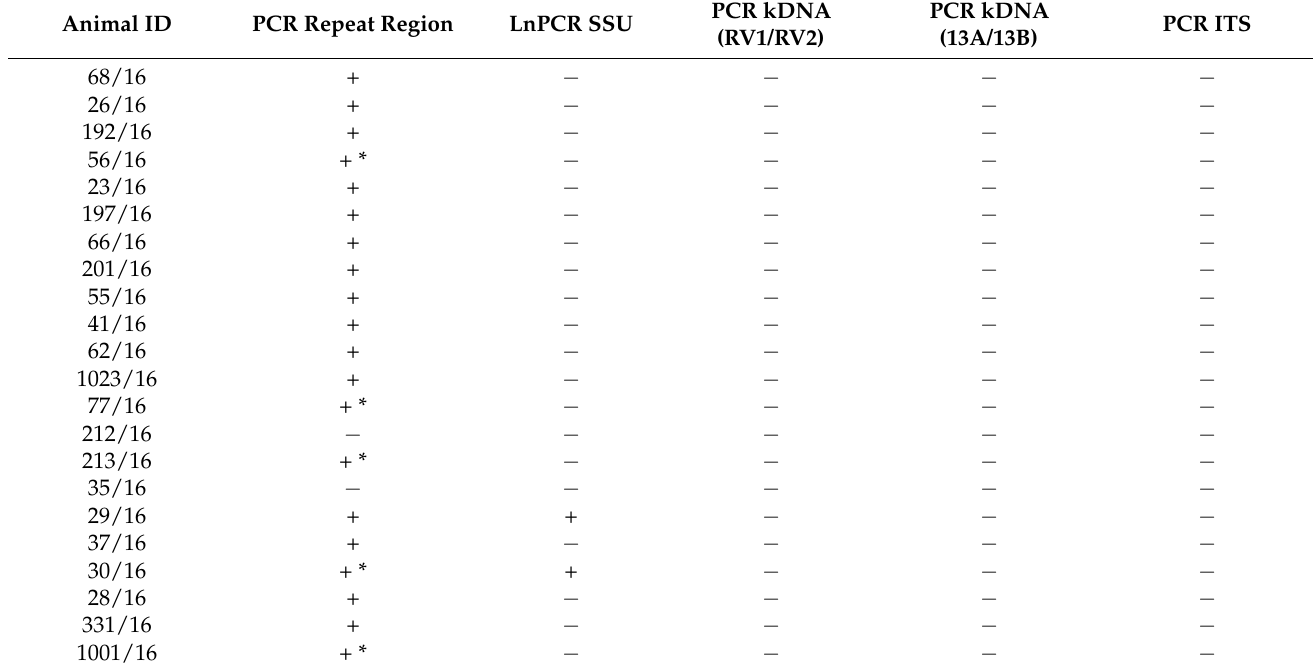
Table 5. PCR amplification from spleen samples using the five PCR protocols used for the detection and identification of L. infantum . PCR of the kDNA region includes primers in parentheses to differentiate the two protocols employed. Animal